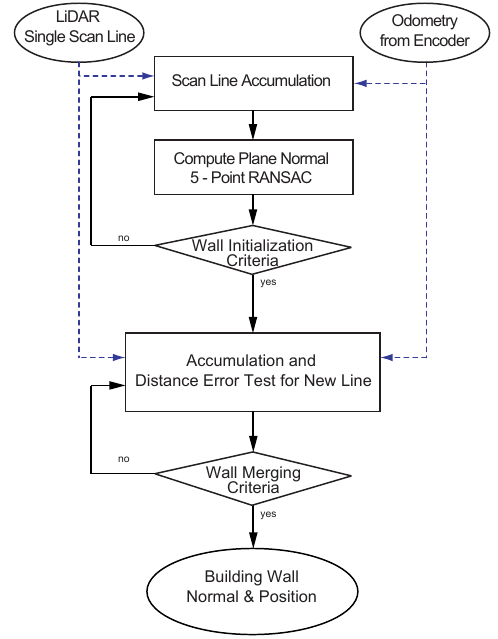
Figure 6. Block diagram for wall segmentation. The overall wall extraction algorithm can be divided into two parts. The first part is to obtain the initial normal, the second is a part of the segmentation wall to error distance test of the new incoming scan line by using initial normal